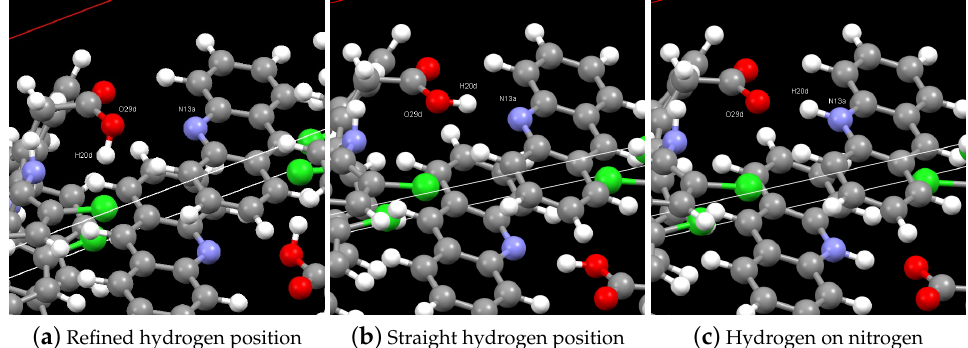
Figure 2. The three different hydrogen configurations